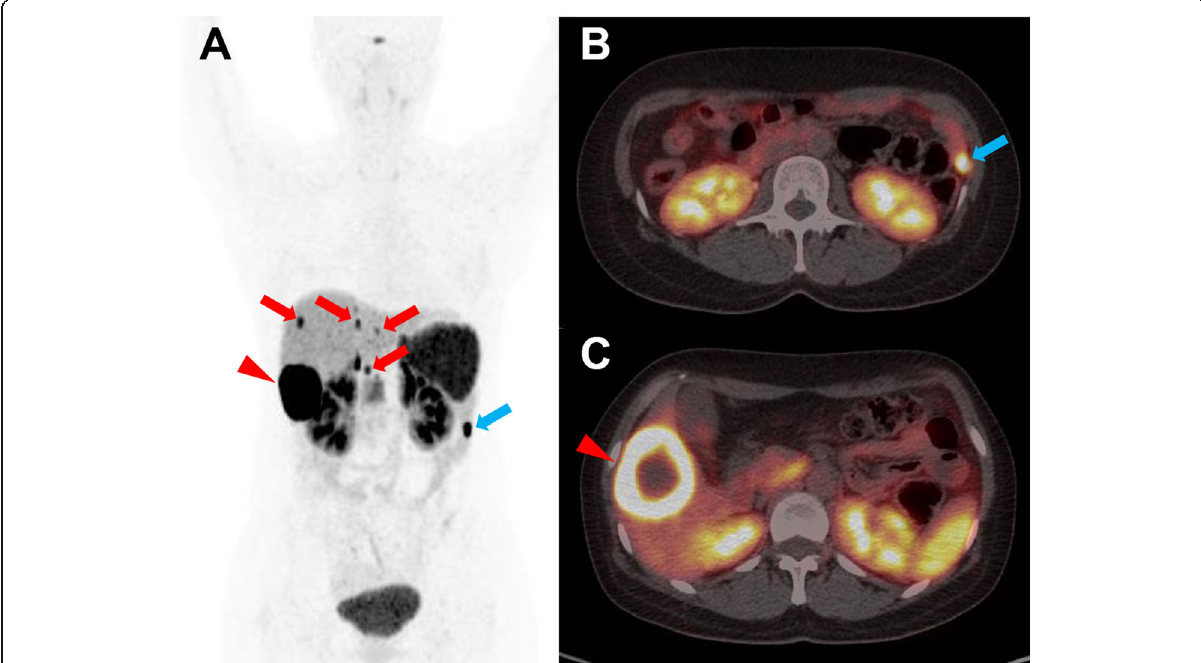
Fig. 4 Representative case of a 37-year-old male with a primary jejunal NET grade 2. MIP ( a ) and trans-axial ( b , c ) [ 68 Ga]Ga-DOTA-TOC PET/CT images reveal primary NET at the jejunal loop (blue arrow) and multiple small (red arrows) and large (red arrowhead) hepatic metastases with intense uptake. He had high TLR (17.7) and high SUVmax (77.5), predicting a good prognosis. However, he had a poor ECOG performance status (1) and high WTV (112.5), predicting poor prognosis. After lanreotide therapy, no progression was found until 30 months of